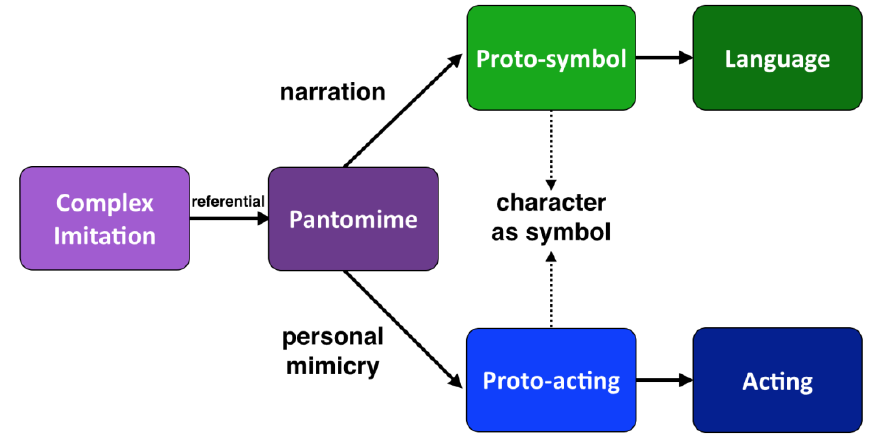
Figure 3. The evolutionary origins of proto-acting. The top tier of the figure represents Arbib’s (2012) model of the gestural origins of language. In it, complex imitation predates pantomime, which is the precursor of proto-symbol, which itself is the precursor of language. The lower tier presents my model of the origins of role playing, in which egocentric pantomime leads to proto-acting via the capacity for personal mimicry and pretense. Proto-acting, then, is the precursor of dramatic acting. The interface between the two tiers is the notion that a character is a symbol and therefore that acting is the symbolic creation of a character.